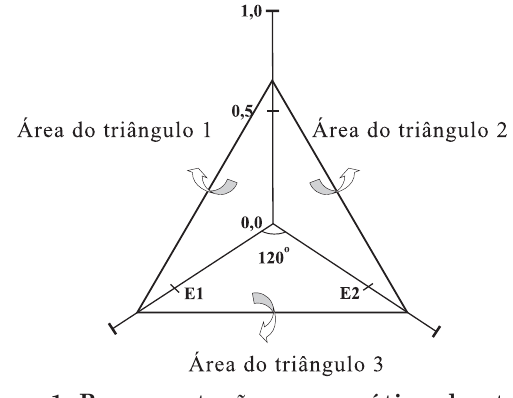
Figura 1. Representação esquemática dos três triângulos internos utilizados no cálculo da área total do triângulo elaborado para cada fonte de nutrientes, dentro de cada sistema de preparo do